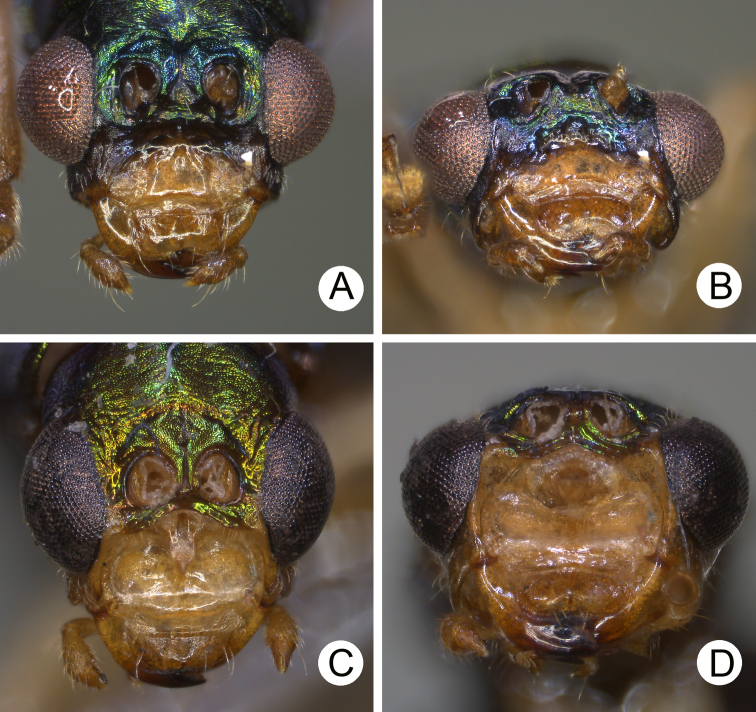
Heads of males of Pseudotheopea
hsingtzungi sp. nov. and P.
smaragdina. AP.
hsingtzungi sp. nov., dorsofrontal view B Same, front view CP.
smaragdina, dorsofrontal view D Same, front view.